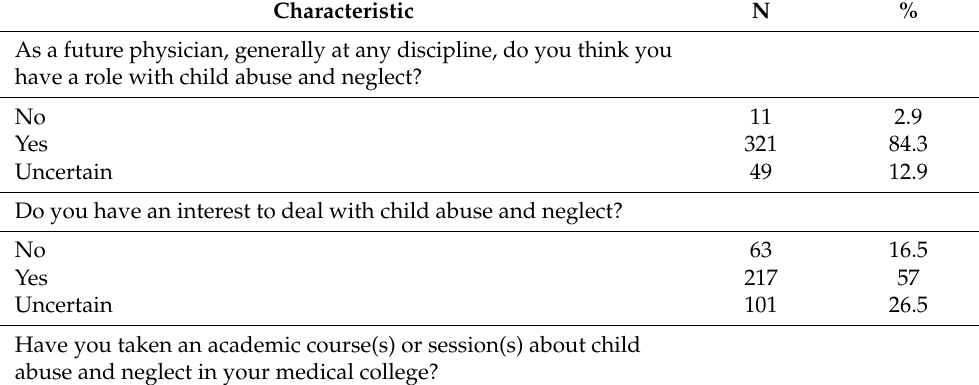
Table 3. Participant’s Opinion on Their Responsibility in the Issue and Importance of Courses or Sessions on Child Abuse and Neglect.